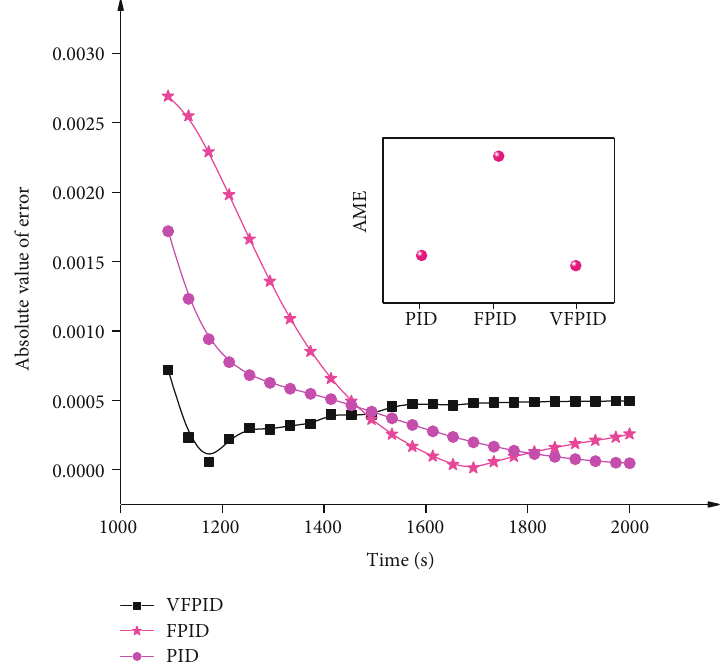
Figure 8: The error absolute value and average magnitude of error (AME) distribution curve.